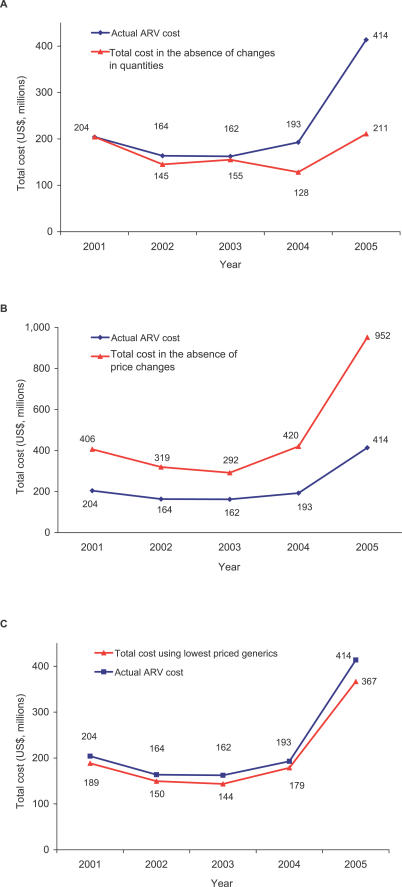
Impact of Alternative Price and Quantity Scenarios on Total ARV Costs, 2001–2005(A) Total Cost Estimates in the Absence of Changes in Drug Quantities, 2001–2005.(B) Total Cost Estimates in the Absence of Changes in Drug Prices, 2001–2005.(C) Total Cost Estimates Using Lowest-Price Generics, 2001–2005.